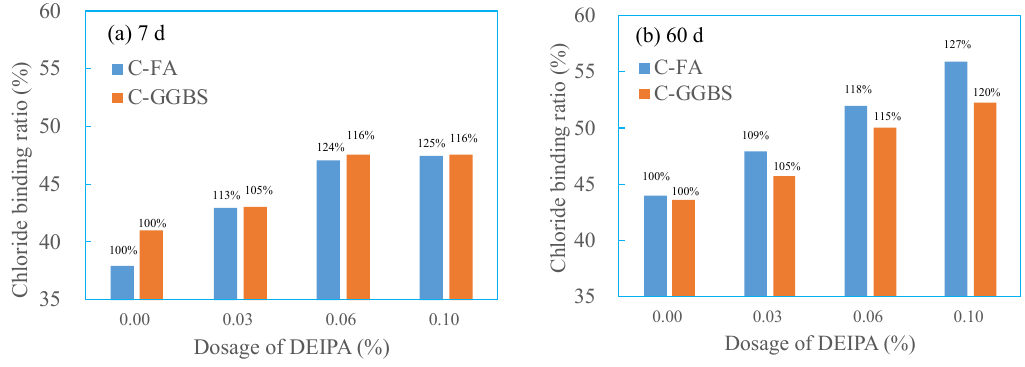
Figure 3. Effect of chloride binding capacity of cement-fly ash system (C-FA) and cement-ground granulated blast furnace slag (C-GGBS), ( a ) 7 d, ( b ) 60 d.